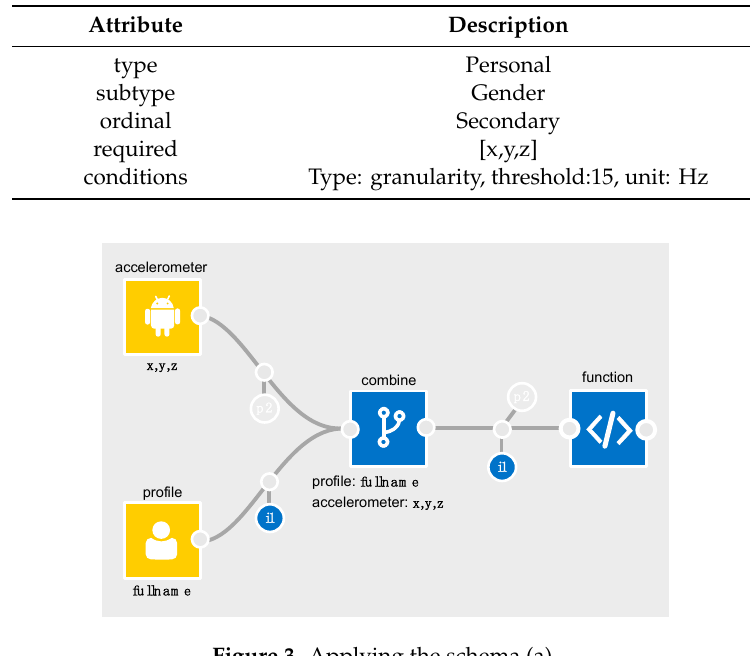
Figure 3. Applying the schema (a).